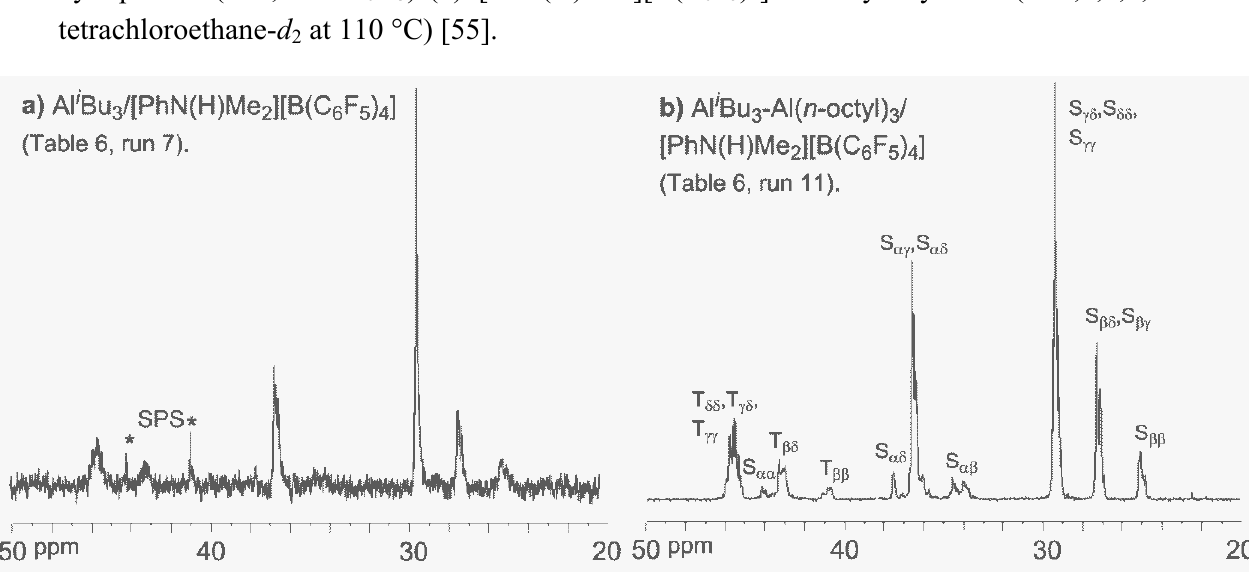
][B(C F ) ]–Al alkyls systems (in 2 6 5 4